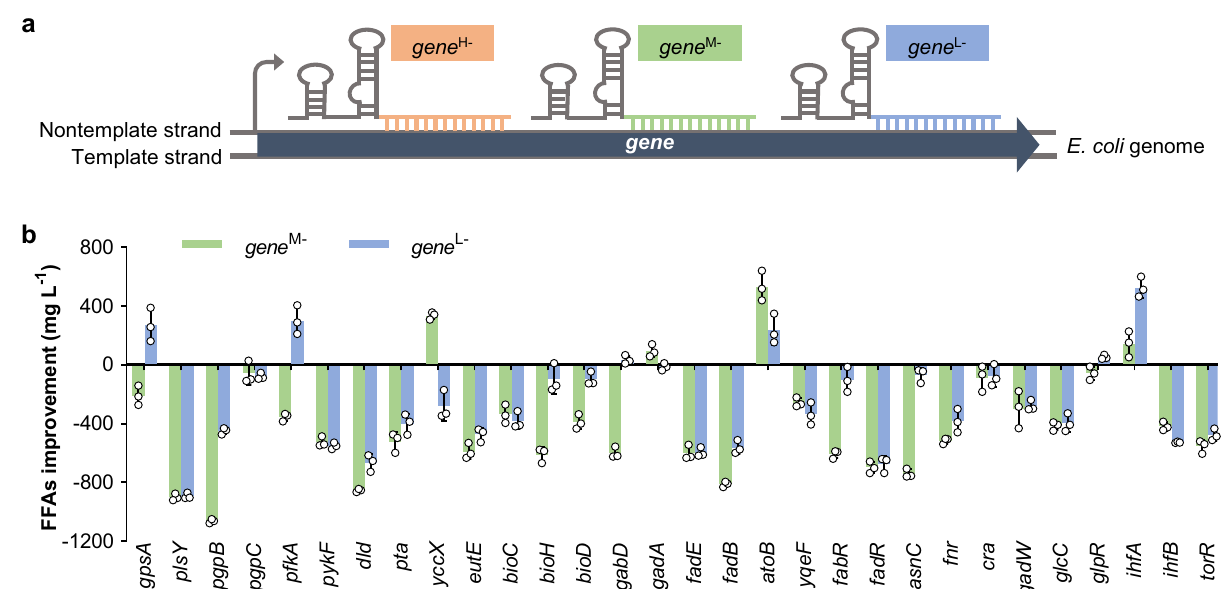
Fig. 3 Tuning of the repression of bene fi cial genes for the improvement of FFAs production. a Design of sgRNAs with high ( gene H − ), medium ( gene M − ), or low ( gene L − ) repression ef fi ciency toward the target gene by binding the nontemplate DNA strand at the initial, middle, or terminal region, respectively. b Improvement of the FFAs titer upon repressing genes with medium or low ef fi ciency compared with the titer obtained upon repressing genes with high ef fi ciency. The gene targets were the genes marked with an asterisk in Fig. 2. The titers were obtained in batch cultivation of 30 g L − 1 glycerol. Data are presented as mean ± SD ( n = 3 biological replicates). Source data underlying ( b ) are provided as a Source Data fi